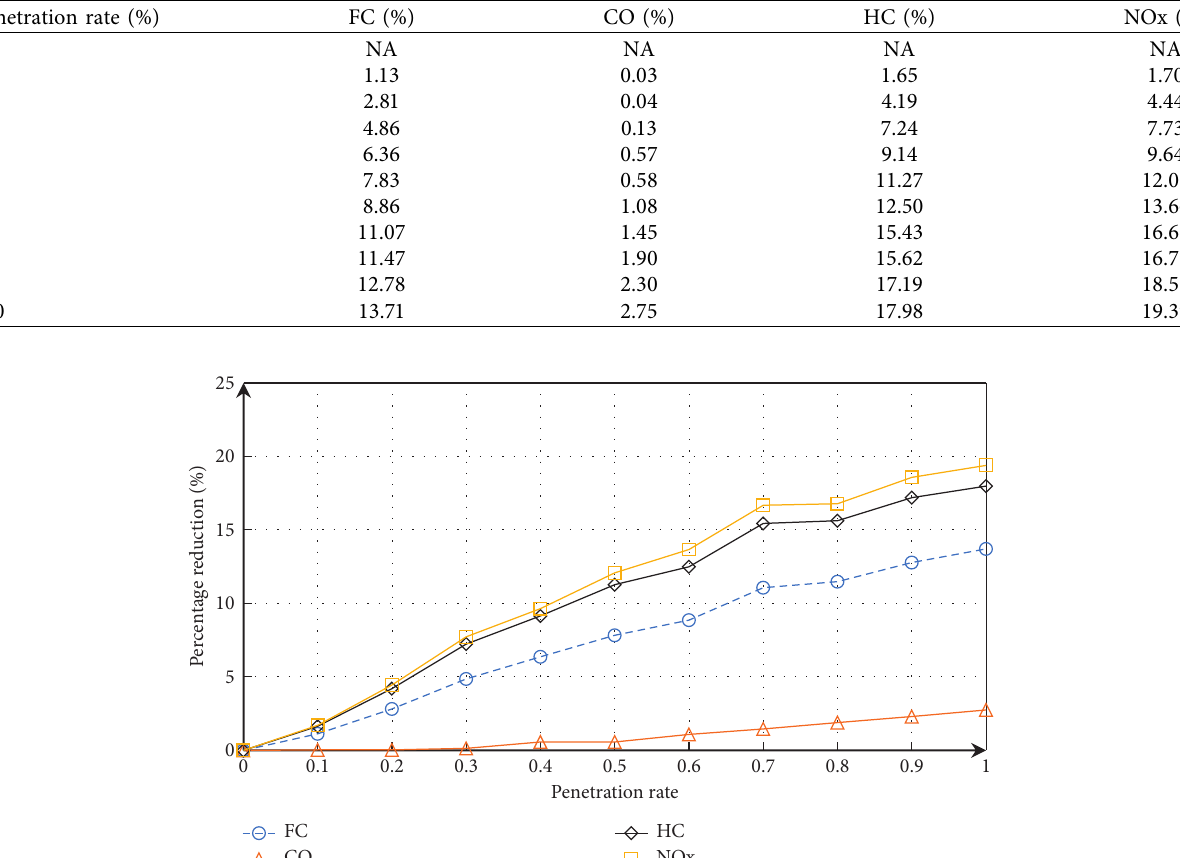
Table 4: Percentage reduction in fuel consumption and traffic emissions (Scenario